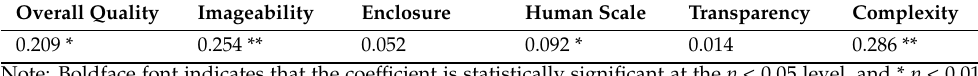
Table 6. Correlation between Walk Score and environmental